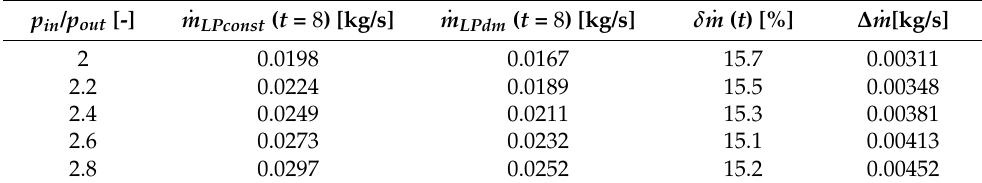
Table 7. Variant B—change of the leakage rate by Equation (18) depending on the pressure ratio p in /p out for the initial geometry 8t and the improved one of the staggered seal RC = 0.315 mm, T in = 300 K, p out = 10 5 Pa .